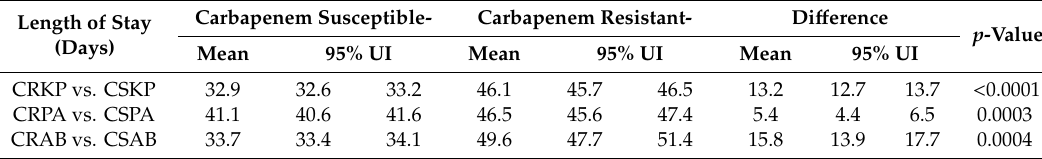
Table 7. Length of stay among patients with CRKP and CSKP, among patients with CRPA and CSPA, and among patients with CRAB and CSAB after PSM for potential confounding variables. Carbapenem Susceptible- Length of Stay (Days)